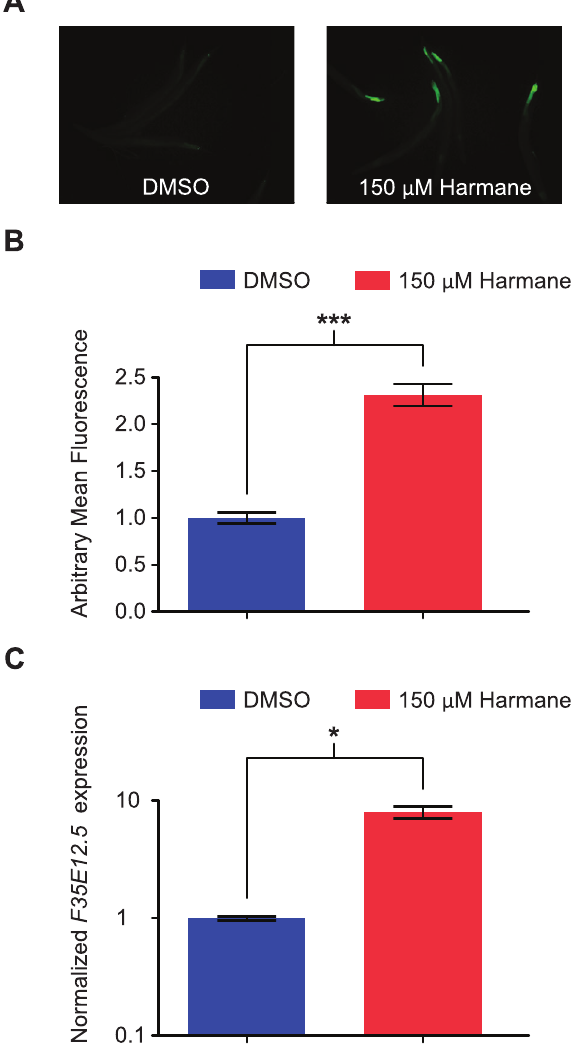
Figure 6. Harmane induces the immune response gene F35E12.5 . (A) Fluorescence microscopy pictures of F35E12.5::gfp transgenic C. elegans , exposed to DMSO or Harmane for 20 hours, at 15 u C (feeding on E. coli OP50). The fluorescence was always seen at the tail end of the animals. (B) Individual nematodes in fluorescence pictures were quantified, and data normalized to the level of the DMSO treated nematodes. There was a significant difference between the two samples [ P , 0.0001; DMSO, n=54; 150 m M Harmane, n=54; error bars indicate SEM]. (C) Verification of F35E12.5 induction by Harmane by qRT- PCR. Bar graphs represent relative expression levels normalized to the control treatment (DMSO). 20 hours treatment with Harmane resulted in a significant induction ( P =0.0175) of F35E12.5 . Error bars indicate SEM derived from two independent biological replicates.